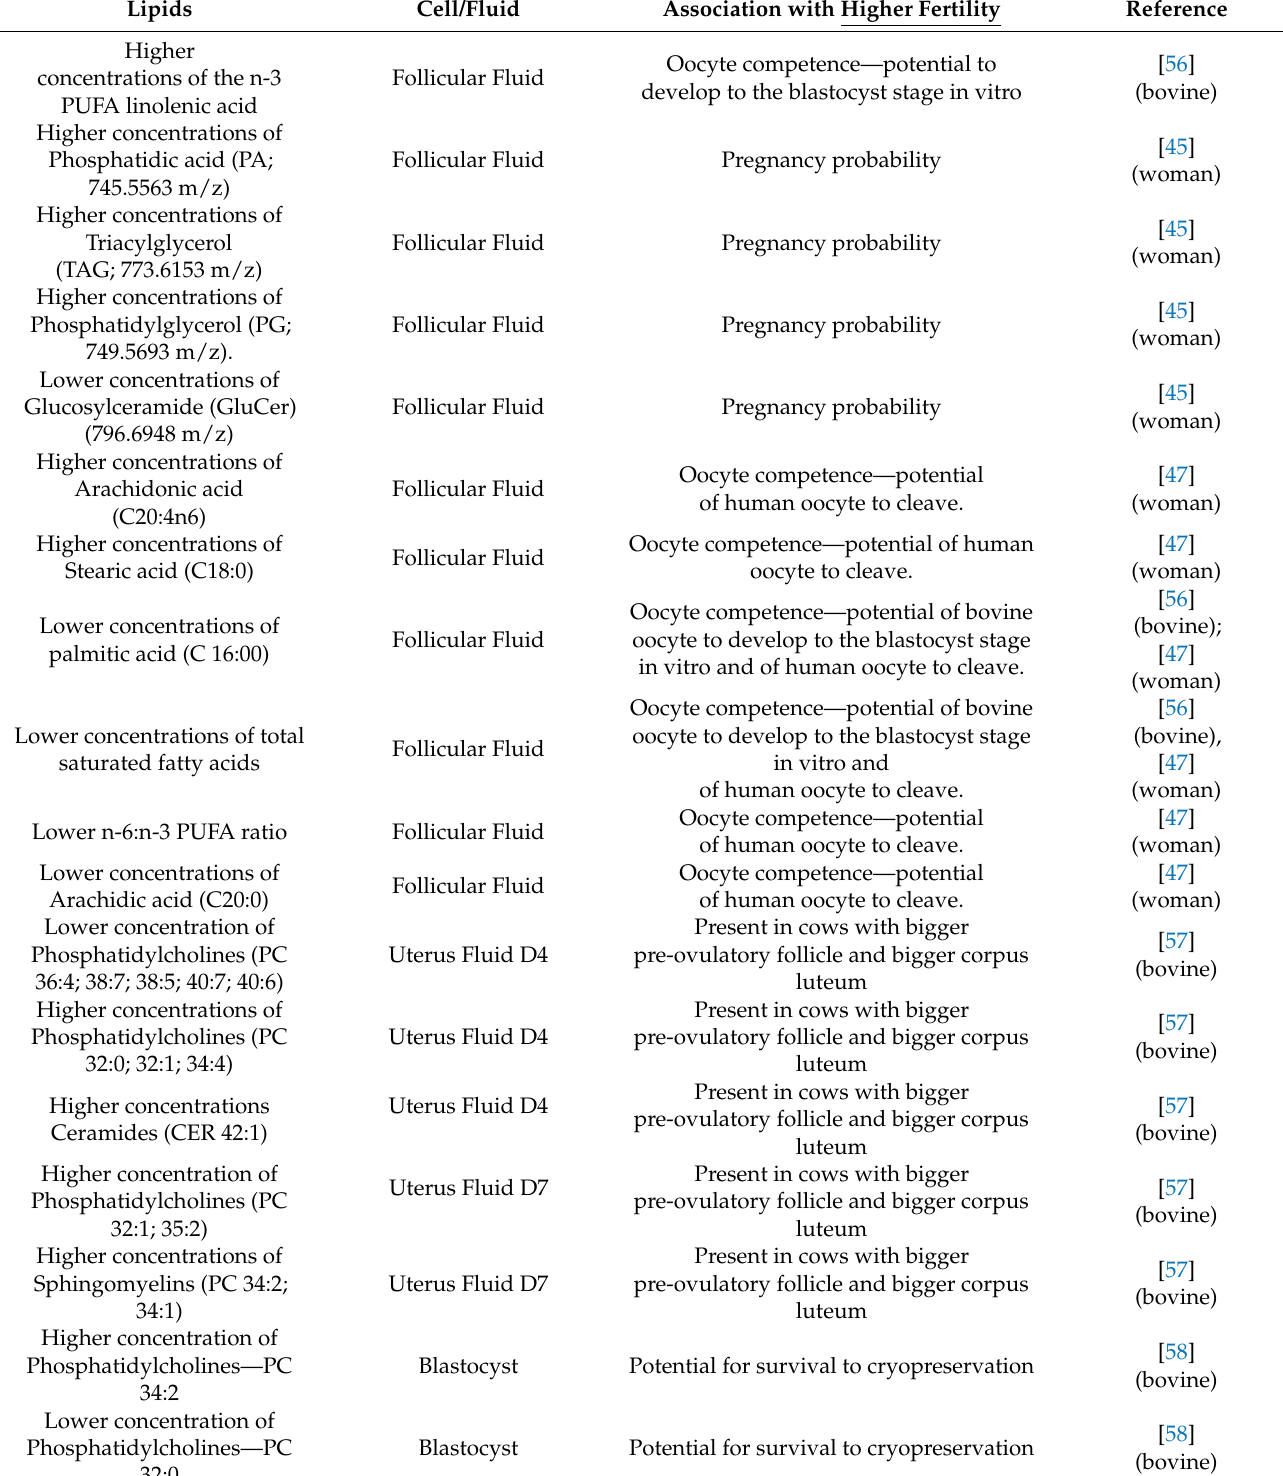
Table 1. Concentration of specific lipid subclasses in tubal fluids and embryos associated with higher fertility. Lipids Cell/Fluid Association with Higher